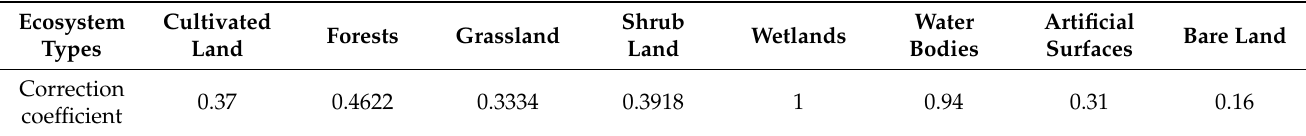
Table 2. Ecological system correction coefficient of different ecological types for the main stream of the Tarim River.